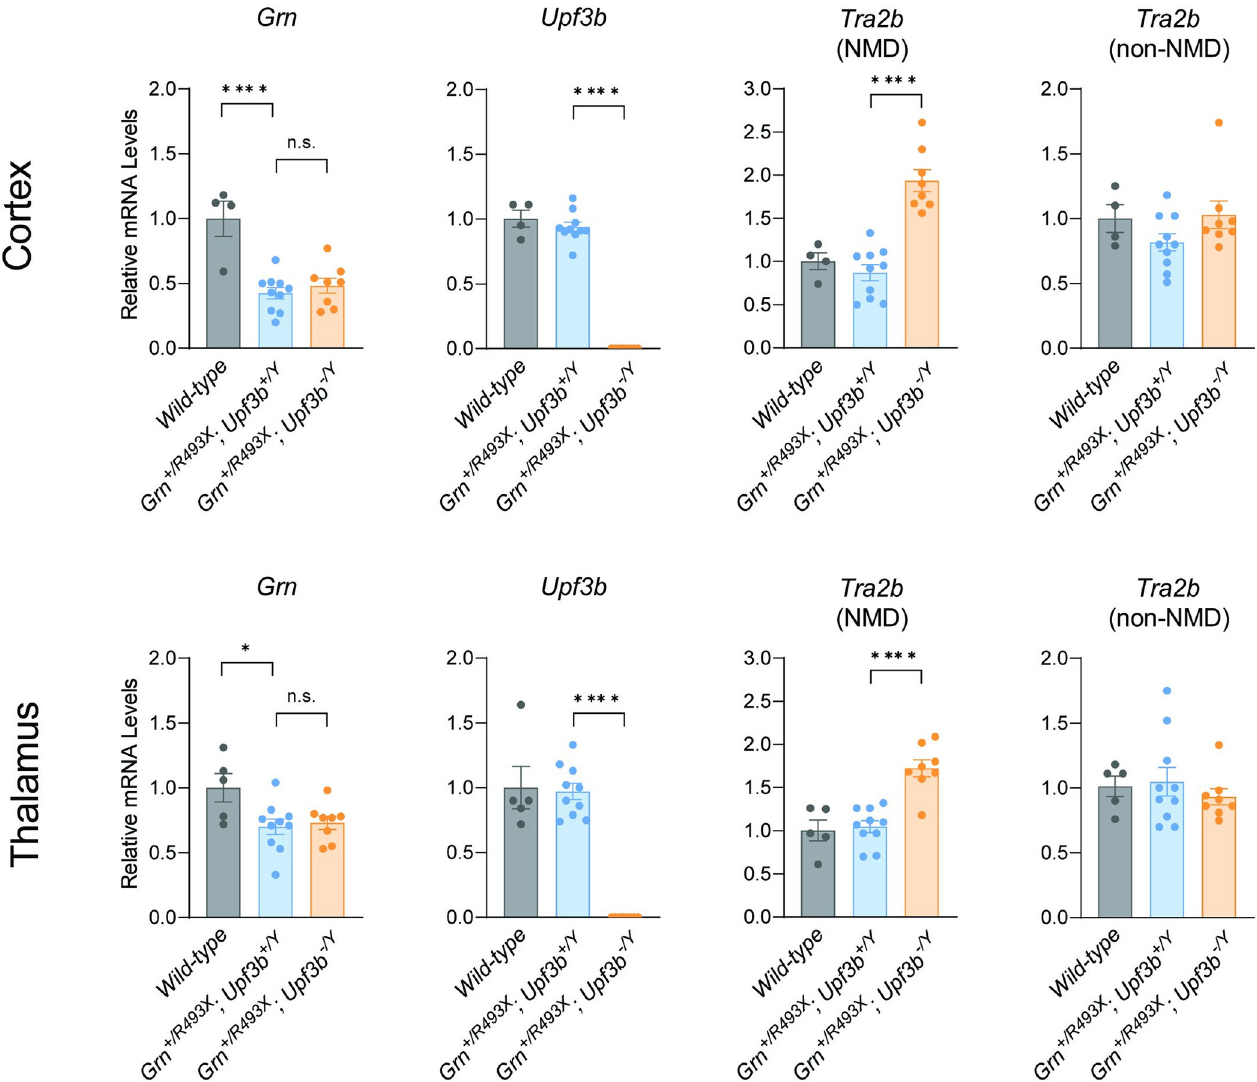
Fig 3. Upf3b deletion does not increase Grn mRNA levels in the brains of Grn +/R493X mice. qPCR results from cortex and thalamus of 10–12 week old male mice. Grn mRNA levels are presented relative to levels in tissues of wild-type mice. Data are presented as means ± SEM; � indicates p < 0.05 and ���� indicates p < 0.0001, as determined by one-way ANOVA with Tukey post hoc test. n.s., not